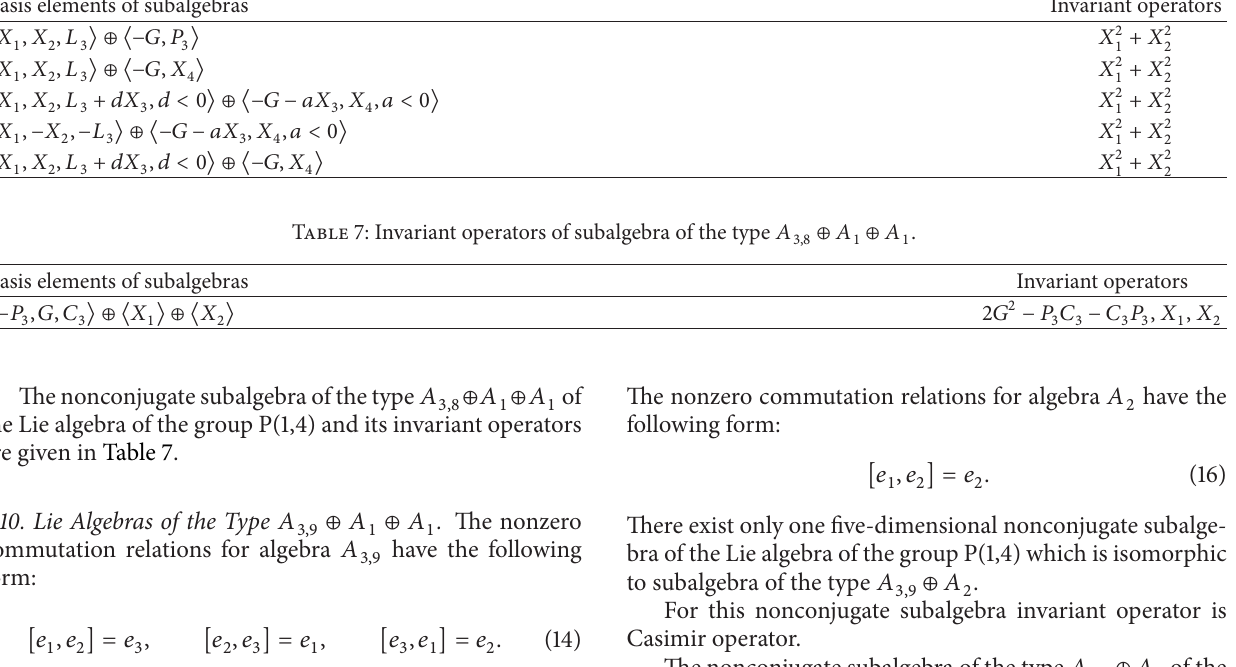
Table 6: Invariant operators of subalgebras of the type 𝐴 3,6 ⊕ 𝐴 2 . Basis elements of subalgebras